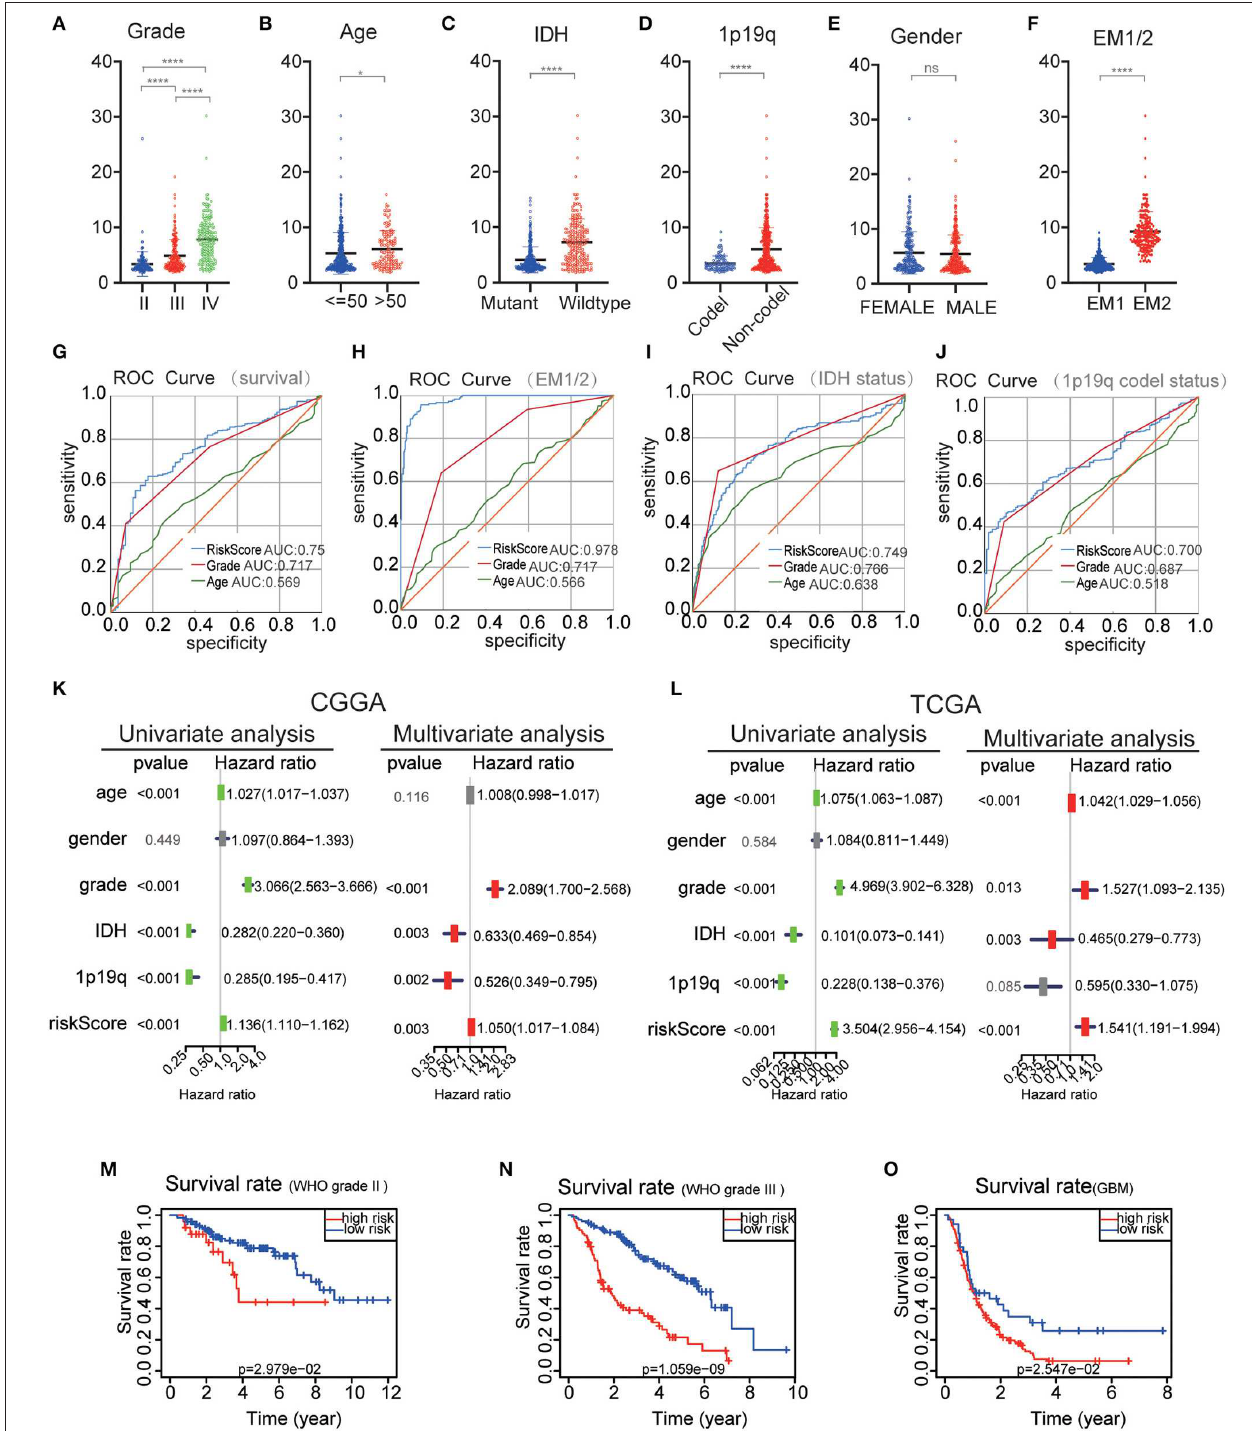
FIGURE 7 | Comparison of risk scores and clinicopathological features between RM1/2 subgroups and differences in different grades of glioma OS. (A–F) Distribution of risk scores in the CGGA dataset stratified by WHO grade (A) , Age (B) , IDH status (C) , 1p/19q codel status (D) , gender (E) , and EM1/2 subgroups (F) . ns no significance, * P < 0.05 and **** P < 0.0001. (G–J) The predictive efficiency of the risk signature, WHO grade, and age on the survival rate (G) , EM1/2 subgroups (H) , IDH-mutant status (I) , and 1p/19q codel status (J) showed by ROC curves. (K,L) Univariate and multivariate Cox regression analyses of the association between clinicopathological factors (including the risk score) and overall survival of patients in the CGGA (K) and TCGA (L) datasets. (M–O) Kaplan–Meier survival curves with different WHO grade groups in the CGGA dataset.